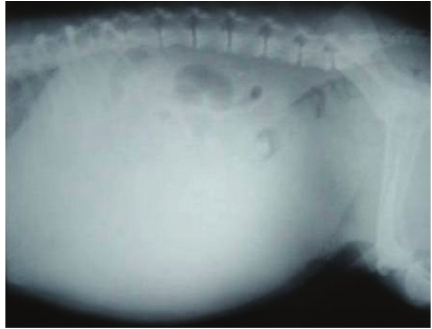
Figure 17: Lateral standing abdominal radiograph of a 7-year-old male mixed-breed ascitic dog with classic “ground glass appear- ance” of abdomen and masking of abdominal cavity details.